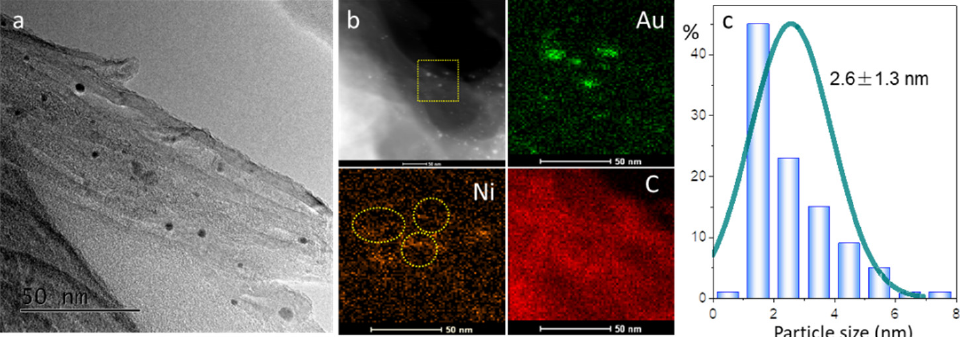
Figure 5. TEM image ( a ), HAADF-STEM elemental mappings ( b ), and the size distribution ( c ) of the AuNi 12 /CNT catalyst.